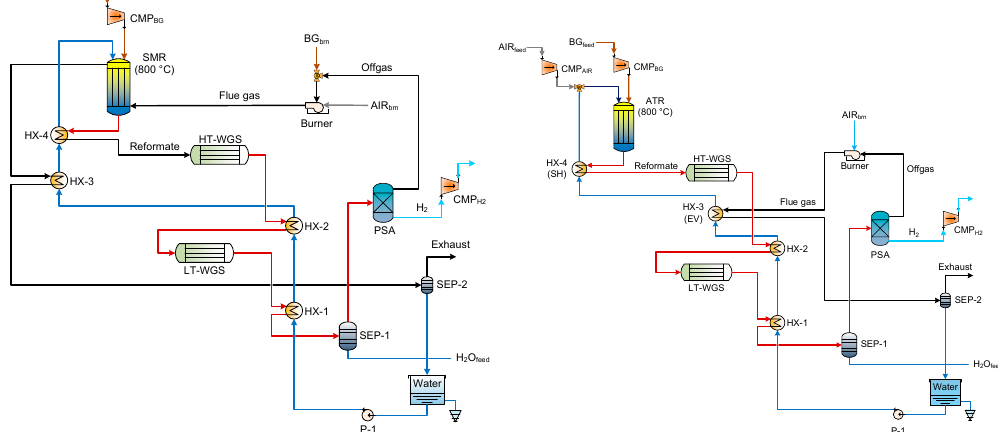
Figure 2. Reference system layouts: steam reformer (SMR) reforming solution (left) and autothermal reformer (ATR) reforming solution (right).